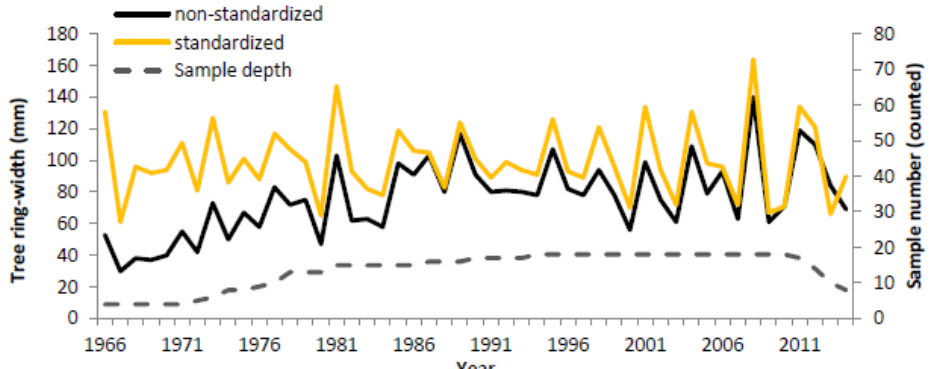
Figure 7. Tree-ring width chronology of Erica arborea in the North Ethiopian highlands (1966–2014). On the graph, the non-standardized tree-ring chronology is given in black and the standardized chronology in orange. The sample number is given with a dashed line, and a minimum of four samples per year is used as a threshold.